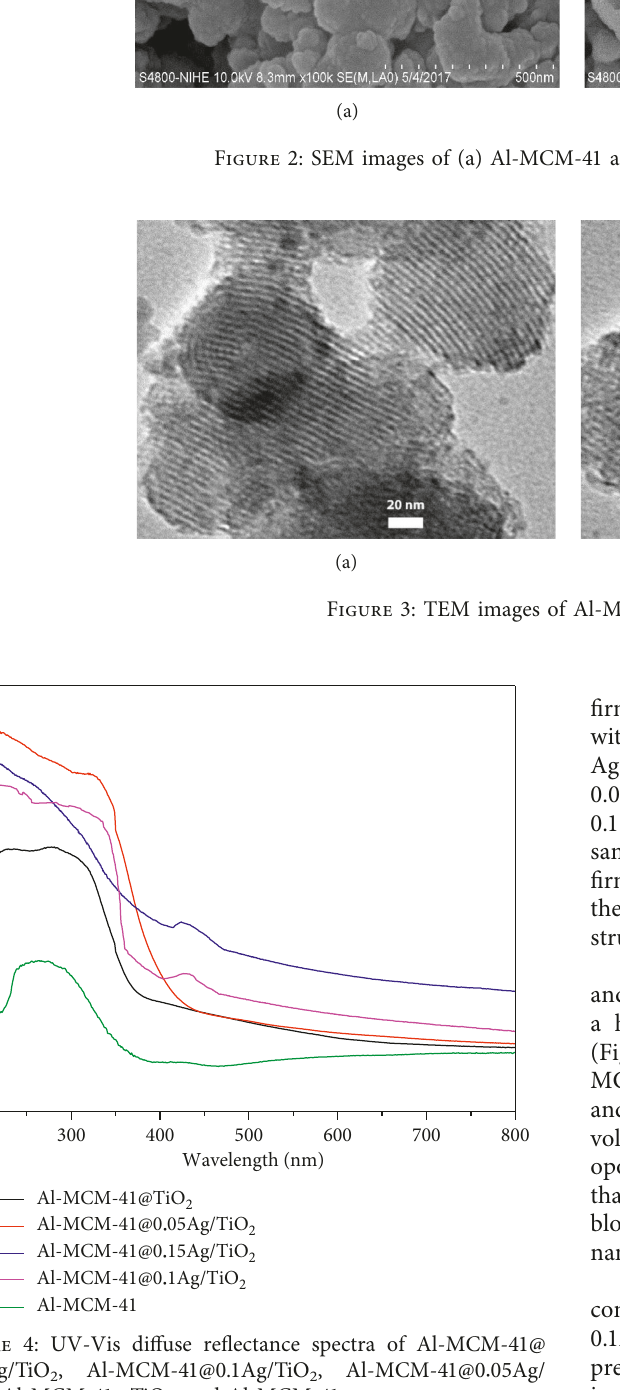
Figure 4: UV-Vis diffuse reflectance spectra of Al-MCM-41@ 0.15Ag/TiO 2 , Al-MCM-41@0 1Ag/TiO 2 , Al-MCM-41@0 05Ag/